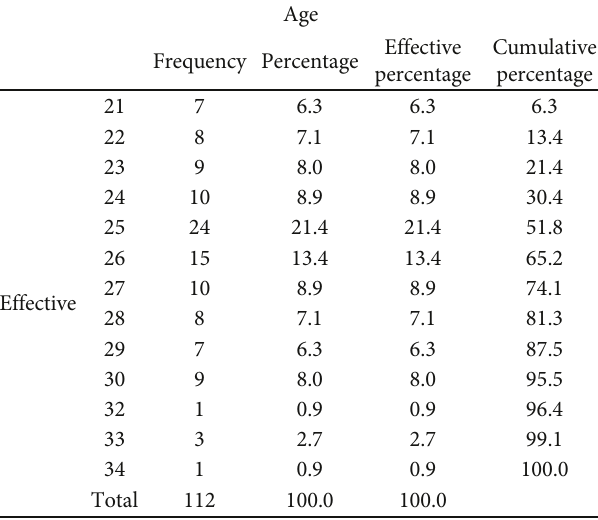
T ABLE 2: Sample age frequency